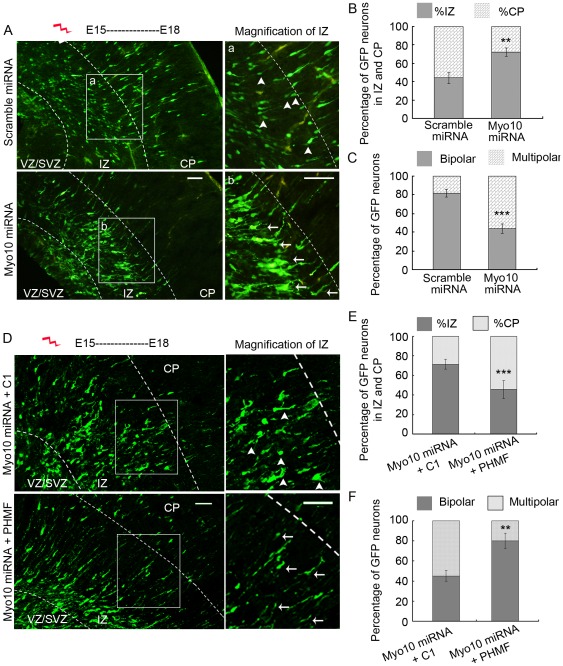
Myo10 miRNA inhibits neuronal transition from multipolar to bipolar in the IZ.A, Images of sections of embryonic neocortex transfected with scramble miRNA and Myo10 miRNA, respectively. Higher magnification of the boxed regions is shown in upper IZ. B, Percentage of GFP-neurons in the IZ and CP. C, Percentage of GFP-neurons with bipolar or multipolar morphologies in the IZ. D, Images of sections of embryonic neocortex transfected with Myo10 miRNA together with pEGFP-C1 or PHMF, respectively. Higher magnification of the boxed regions is shown in upper IZ. E, Percentage of GFP-neurons in the IZ and CP. F, Percentage of GFP-neurons with bipolar or multipolar morphologies in the IZ. Scale bar, 50 µm. **P<0.01; ***P<0.001.